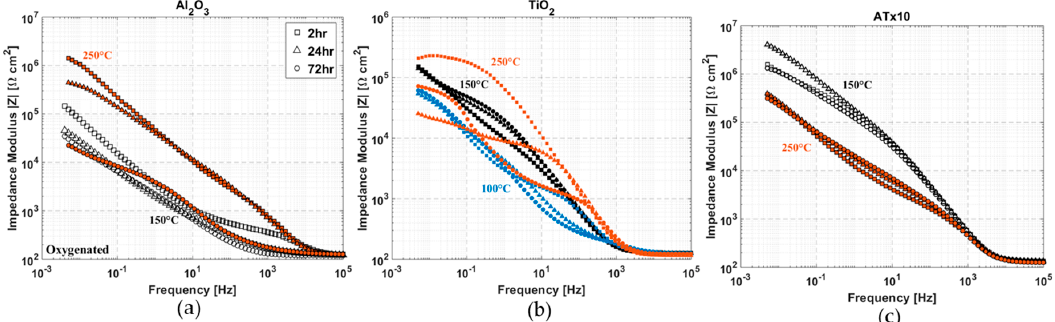
Figure 14. Impedance modulus versus frequency at selected immersion times over 72 h in oxygenated 0.1 M NaCl for various ALD substrate temperatures: ( a ) Al 2 O 3 -coated Cu; ( b ) TiO 2 -coated Cu; and ( c ) ATx10 [(Al 2 O 3 +TiO 2 )x10]-coated Cu. In ( a ) and ( c ) unfilled shapes (black) represent a substrate temperature of 150 °C during deposition and filled shapes (red) indicate 250 °C substrate temperature. In ( b ) substrate temperatures are: 250 °C—red, 150 °C—black, and 100 °C—blue. Deposition temperatures are also provided on each plot, and all films are nominally 50 nm thick.